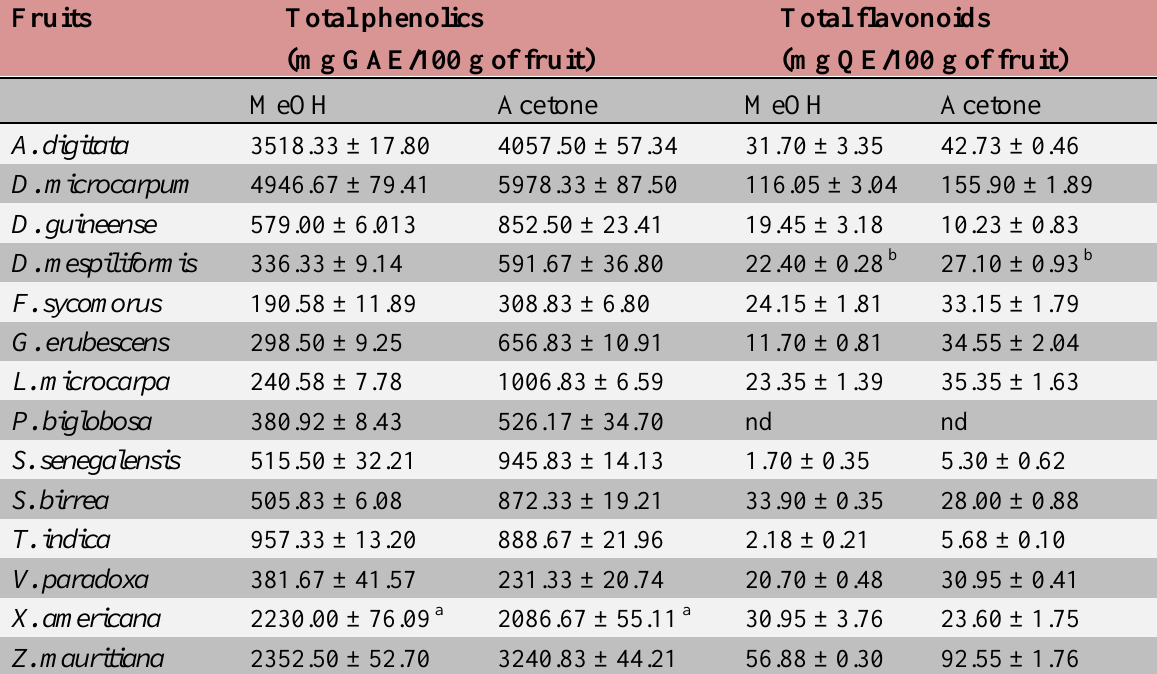
Table 2. Total phenolic and Total flavonoid levels for fourteen fruit extracts (MeOH 70%, Acetone 70%, pH 2). Results are mean ± SD (n = 6).